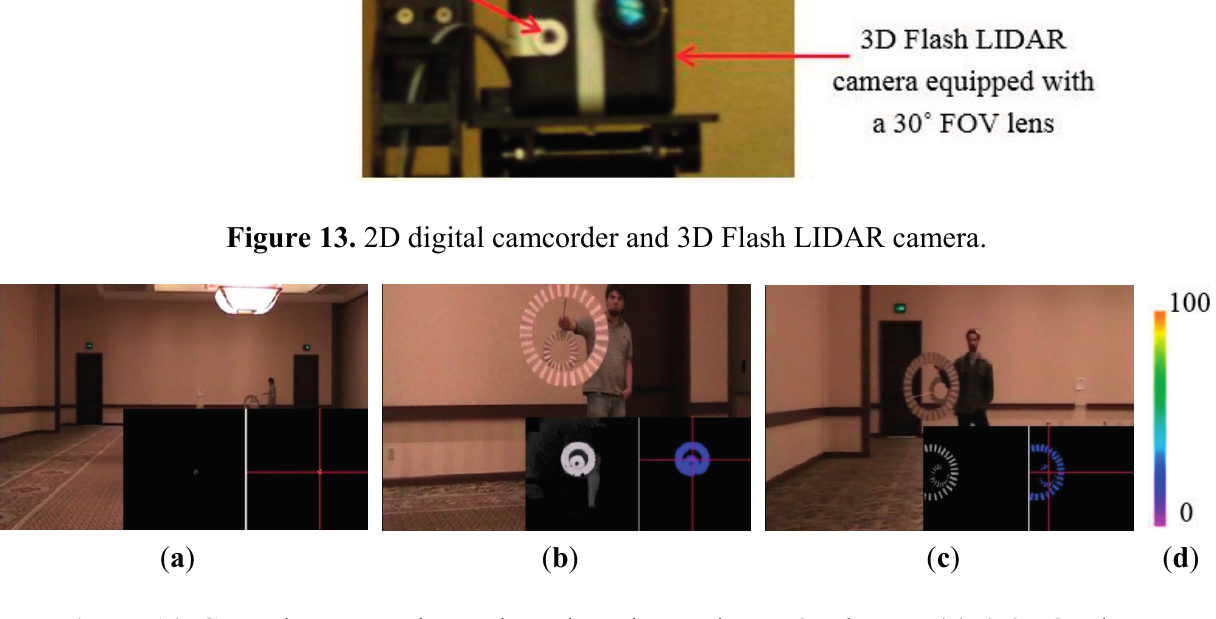
Figure 14. Ground test experimental results using various FOV lenses: ( a ) 45° FOV lens; ( b ) 30° FOV lens; and ( c ) 9° FOV lens; ( d ) Color palette from 0 feet (0 m) to 100 feet (30.48 m).